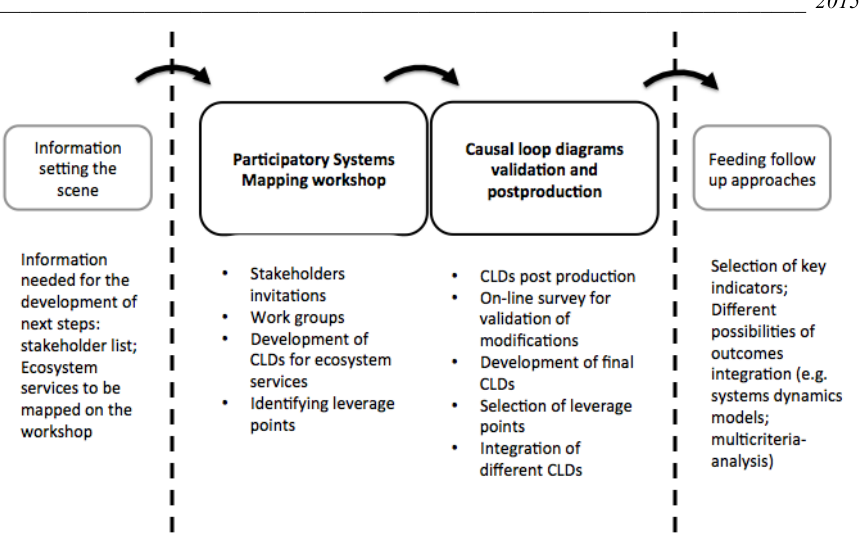
Fig. 1. Methodology for participatory systems mapping of ecosystem